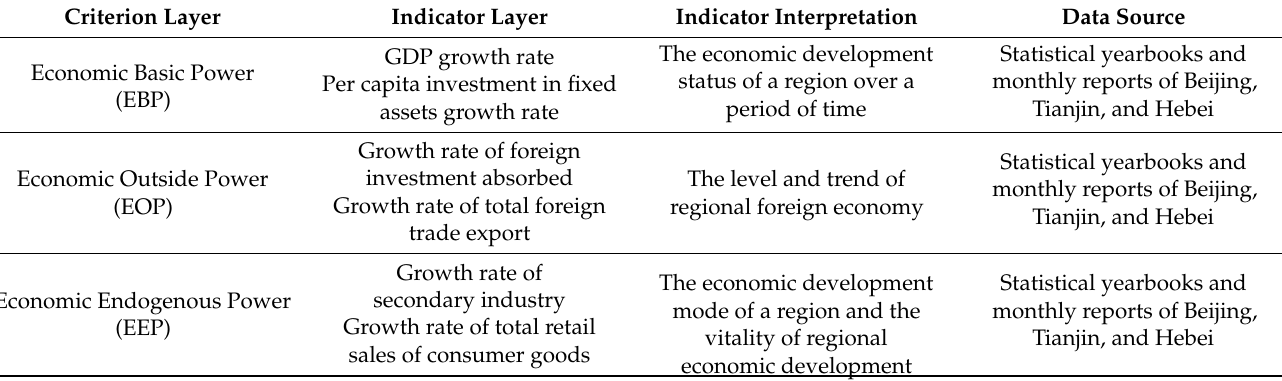
Table 2. The EDI System of Beijing–Tianjin–Hebei Urban